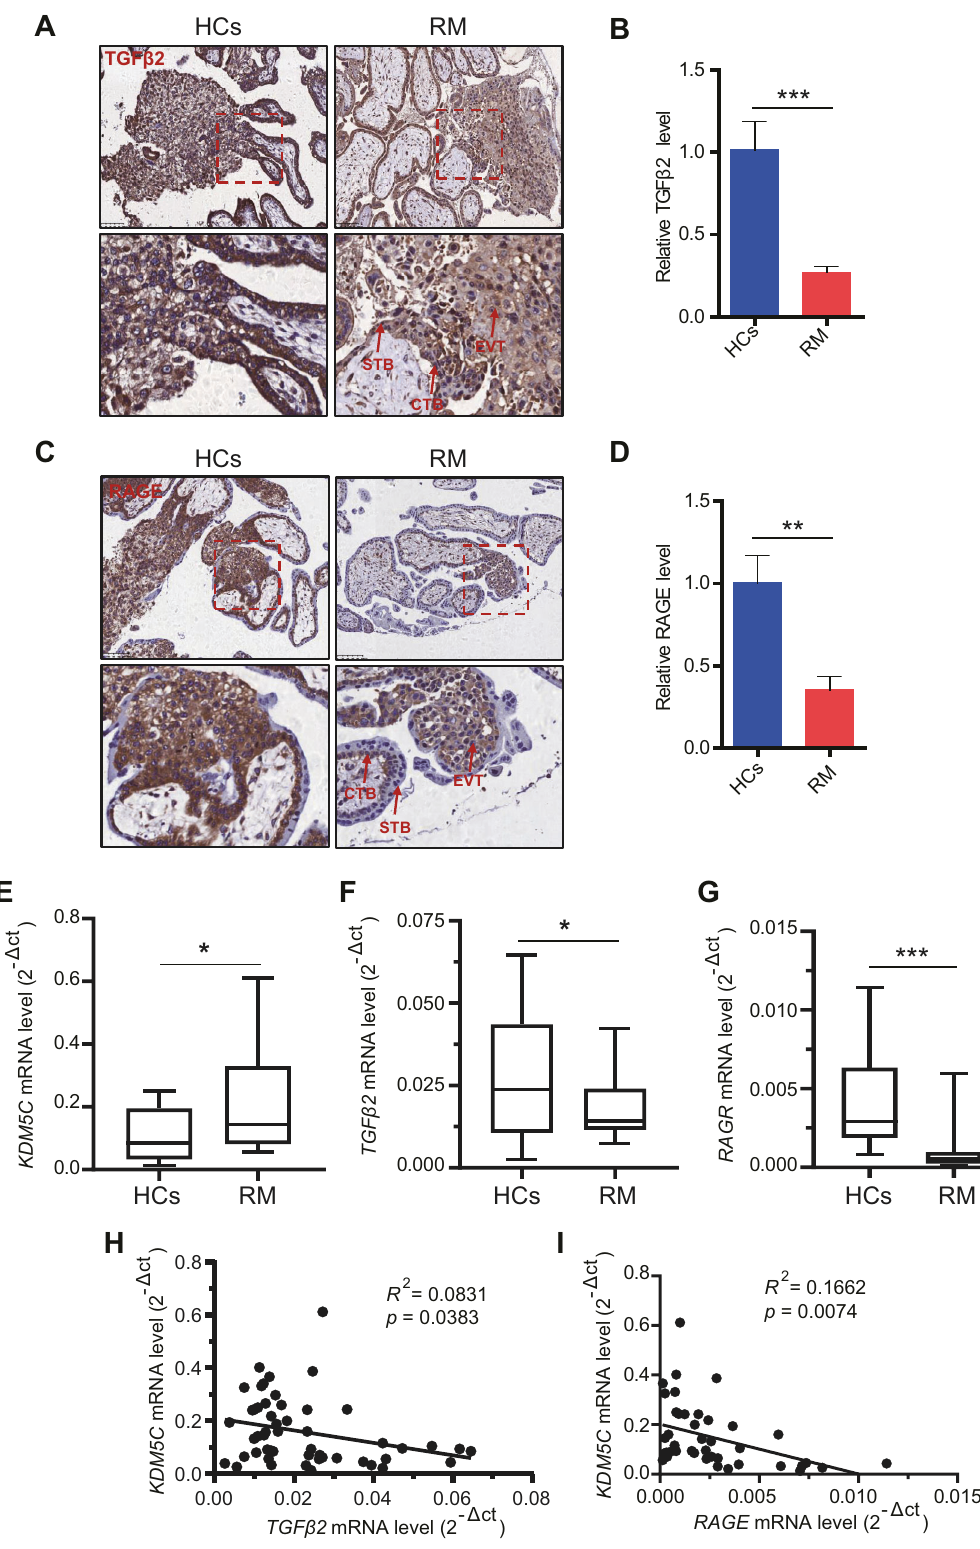
Fig. 7 TGF β 2 and RAGE negatively correlate with KDM5C in RM patients. Immunolabeling of villi tissue from HCs and RM patients with anti- TGF β 2 antibody ( A , B ), or anti-RAGE antibody ( C , D ), which were visualized using a HRP kit. Sections were hematoxylin counterstained, and cell positivity was quanti fi ed using Image-Pro Plus 6.0 software ( n = 10); Scale bar = 100 μ M. STB, syncytiotrophoblast; CTB, cytotrophoblast; EVT: extravillous trophoblast. The mRNA levels of KDM5C ( E ), TGF β 2 ( F ), and RAGE ( G ) found in villi from HCs ( n = 25) and RM patients ( n = 29) were detected using qRT-PCR. (H, I) level of KDM5C mRNA was negatively associated with level of TGF β 2 or RAGE mRNA in RM patients ’ villous tissues and HCs. Data are shown as the mean ±SEM; Student ’ s t test was used to evaluate the statistical signi fi cance; * p < 0.05, ** p < 0.01, *** p < 0.001.